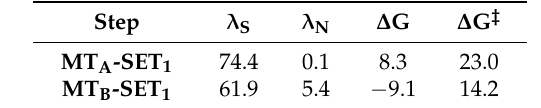
Table 1. Marcus theory calculated values for the two models for the first SET step. Energies in kcal/mol.